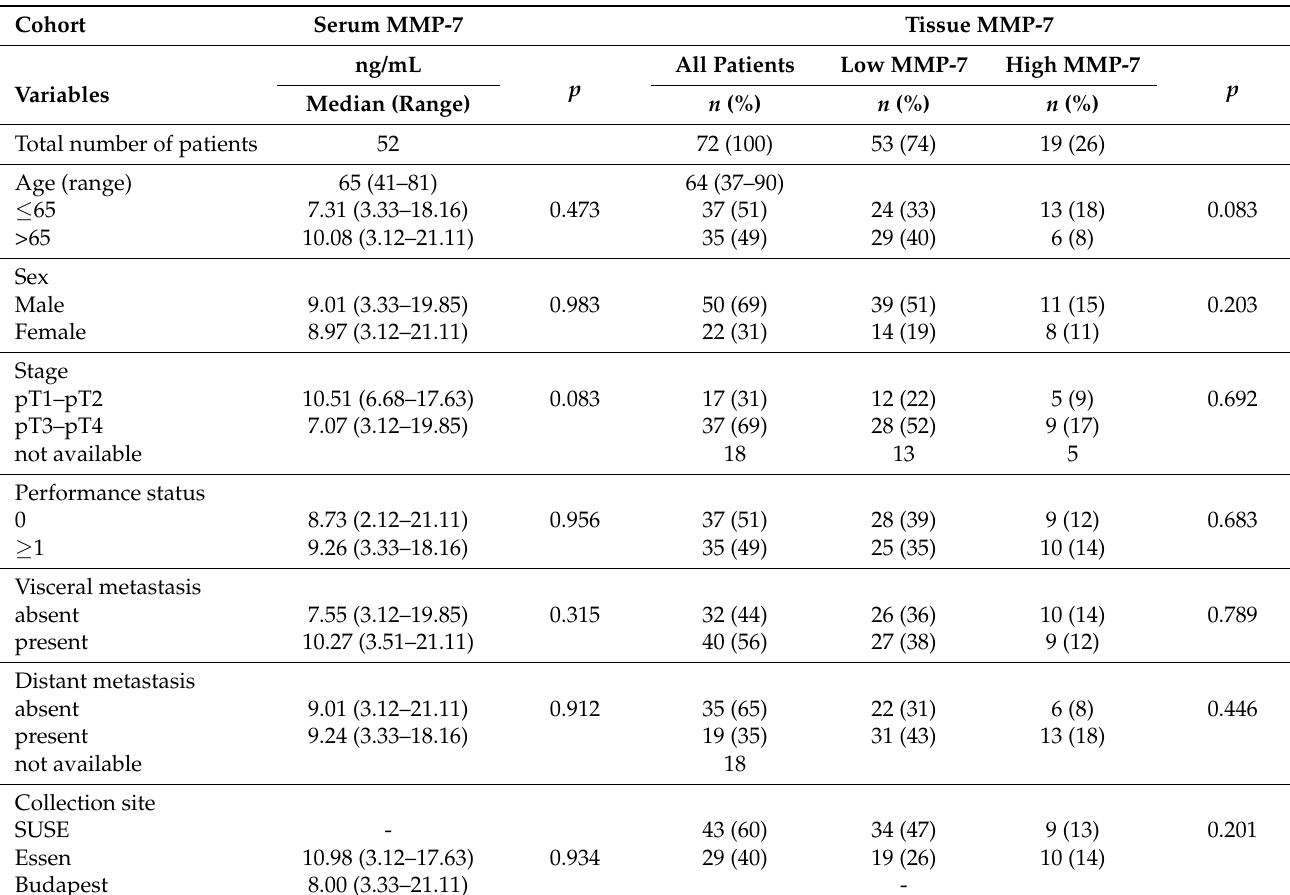
Table 2. MMP-7 serum and tissue levels and clinicopathological parameters. Low MMP-7 tissue expression (score ≤ 3) and high MMP-7 tissue expression (score >